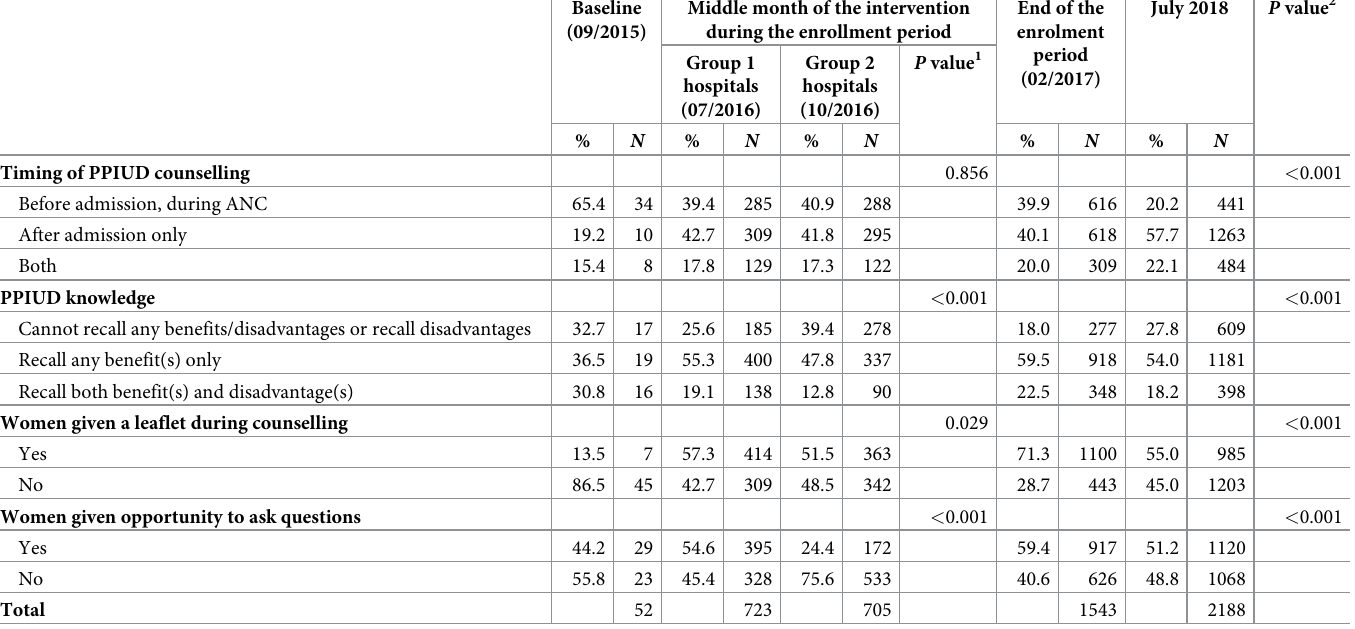
Table 2. Percentage of women reporting PPIUD counselling and PPIUD knowledge, if counselled,